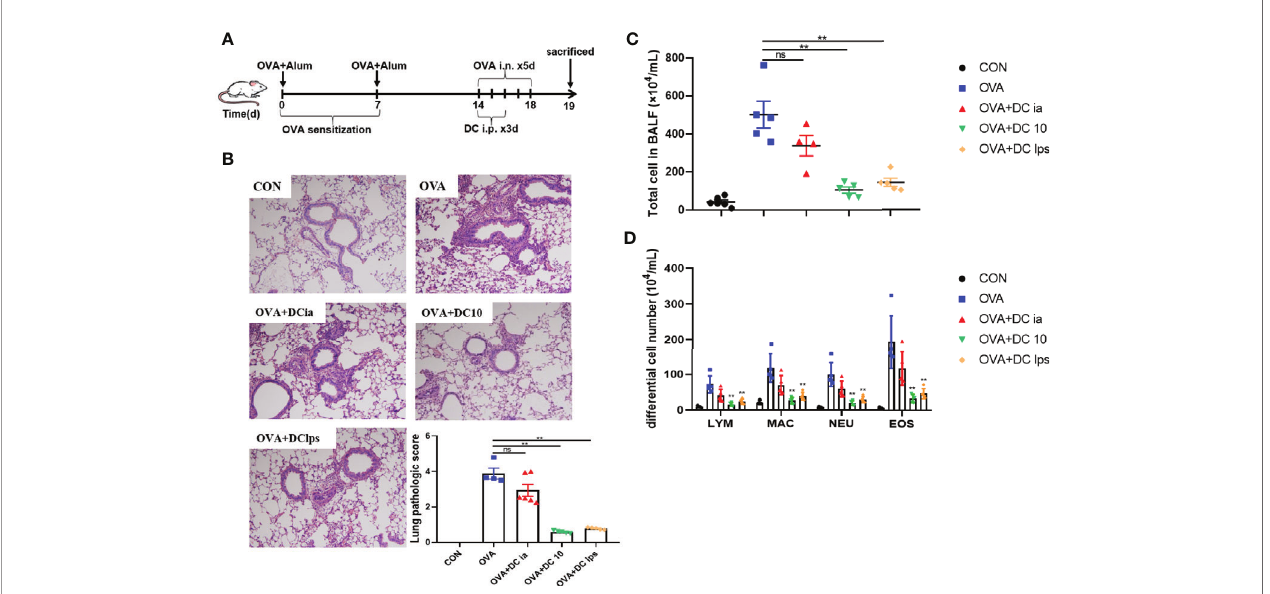
FIGURE 2 | Adoptive transfer of DClps alleviated airway in fl ammation in OVA-induced asthmatic mice. (A) An asthma model was induced in C57BL/6 mice by OVA- sensitization/challenge. DCia, DC10 or DClps were transperitoneally transferred to OVA-sensitized mice. (B) Representative H&E stain of lung (100×) and lung pathologic score. (C, D) Total and differential cell in BALF. The columns and error bars represent the mean and SEM. (**P < 0.01, ns, no signi fi cant difference, compared with the OVA group, ANOVA with Tukey ’ s post hoc analysis). The same experiment was repeated three times with similar results (n = 5 in each